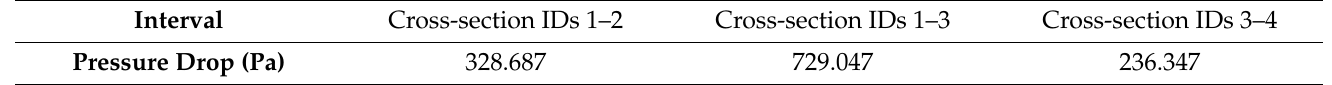
Figure 15. The pressure features inside the Zigzag tunnel ( Re in = 2500). Table 3. The pressure drop during different cross-sections ( Re in = 2500).